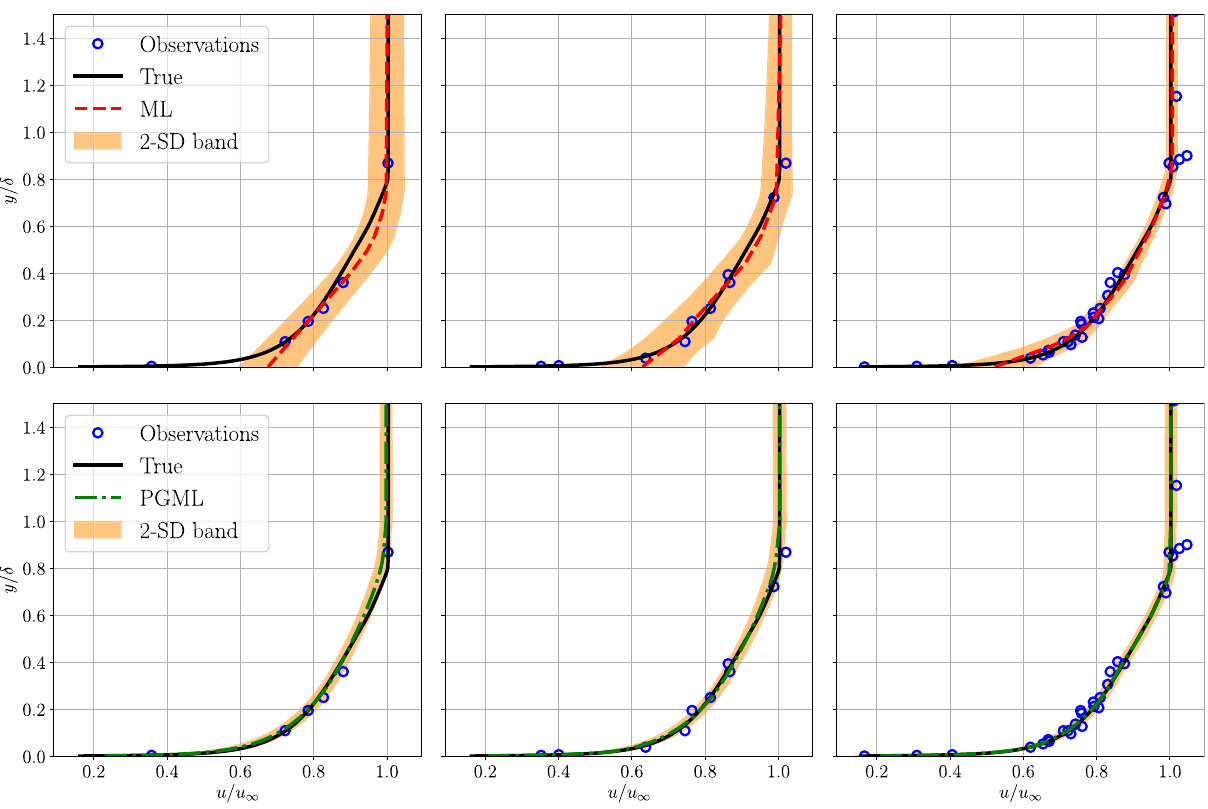
Figure 4. Boundary layer prediction for turbulent flat plate flow at x / L = 0.5 along with the observations used for training the ML and PGML model. The amount of observations data used for training the model is 5% (left), 10% (middle), and 30% (right). The shaded area corresponds to two standard deviation (2-SD)